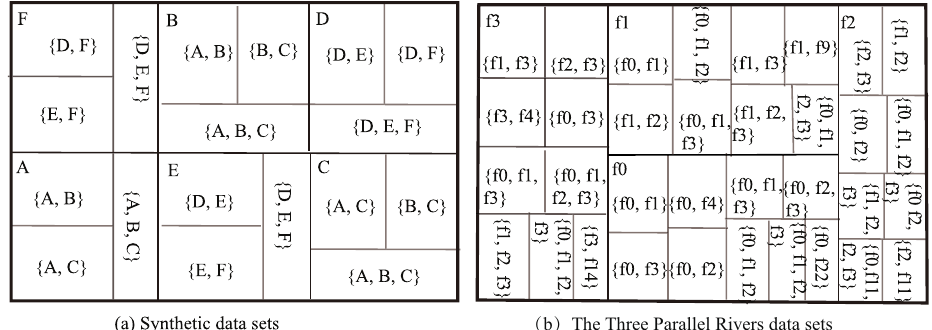
Figure 7. The dendrograms of type- β co-location pattern examples in the given data sets. ( a ) Since the closeness centrality of each feature is similar to each other in the given examples with β -CPM ( α = 2, β = 0.3, ζ = 0.5), the closeness centrality of each feature is similar to each other. ( b ) The closeness centrality of f2 is obviously lower than f0, f1, and f2. It is a secondary contradiction in {f0, f1, f2, f3} with β -CPM ( α = 3, β = 0.5, and ζ = 0.3). Furthermore, they are f3, f0, f1, and f2 in order of